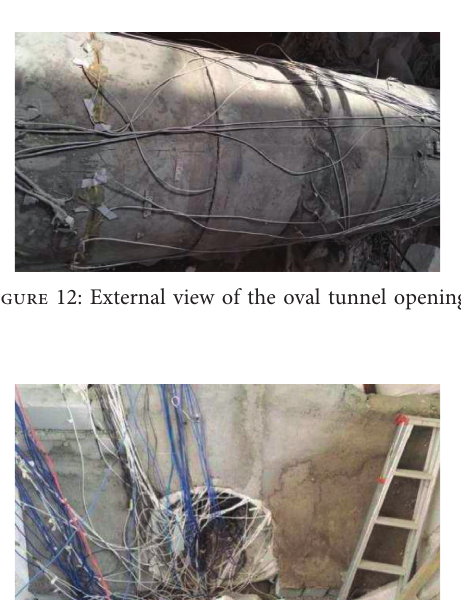
Figure 15: Circumferential strain inside the tunnel portal (7.237Hz).